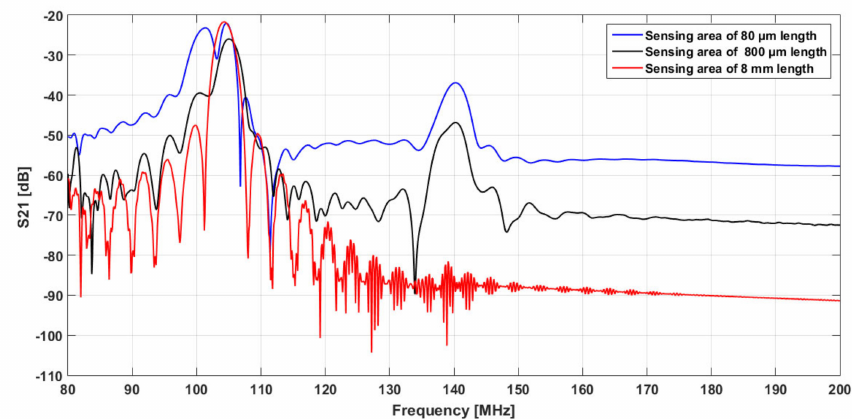
Figure 6. Simulated S21 spectra for di ff erent length of sensitive